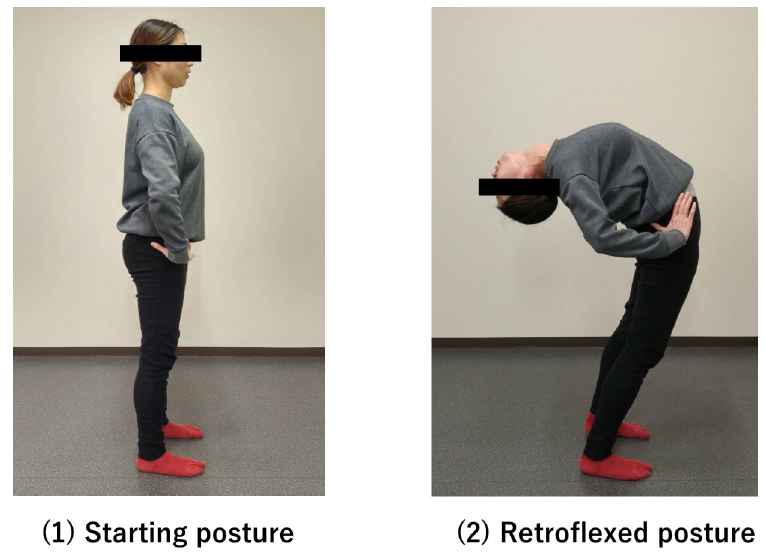
Figure 1. Instructions for trunk extension angle measurement: From the starting position, bend over backwards and hold a position of maximum extension for 3 backwards and hold a position of maximum extension for 3 s.